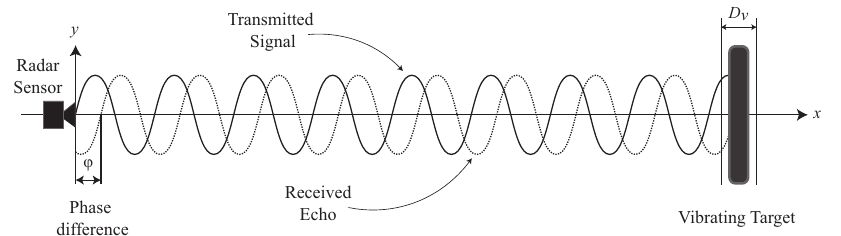
Figure 3. Working principle of radar vibrometry: the head of the radar transmits the signal and because of the target vibration, the received echo exhibits a phase delay ψ . The x -axis represents the range, and the y -axis represents the cross-range. D v is the target displacement along the radial direction of the target